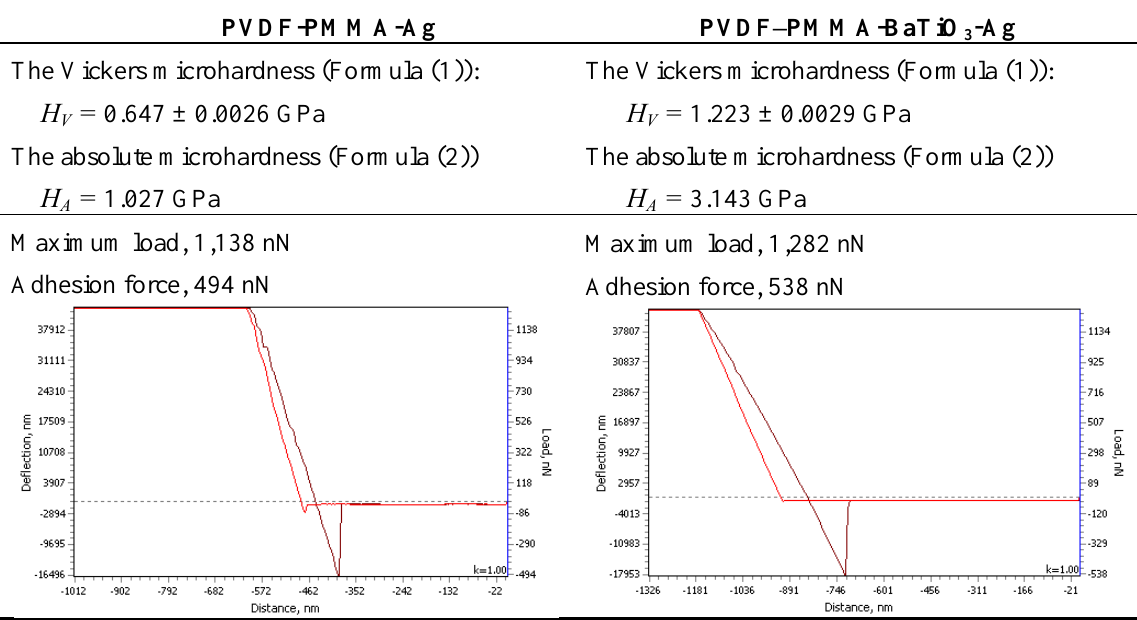
Table 2. Mechanical properties of piezoelectric–plasmonic